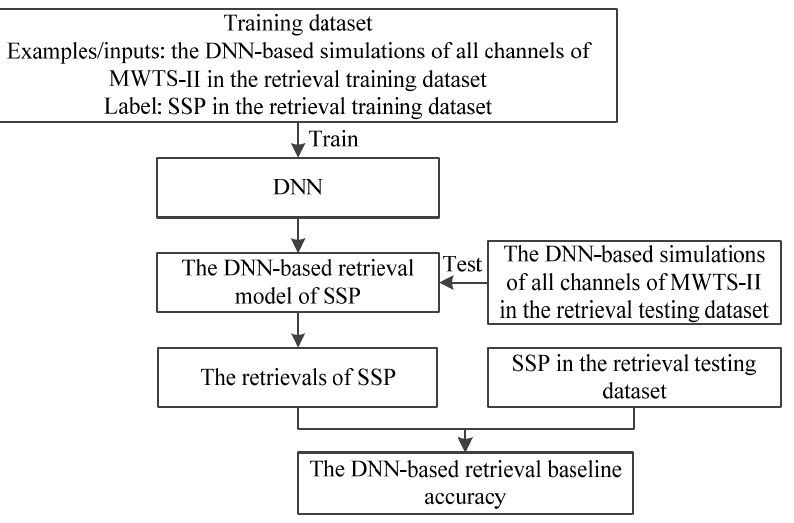
Figure 3. The schematic of obtaining the DNN-based retrieval baseline accuracy.